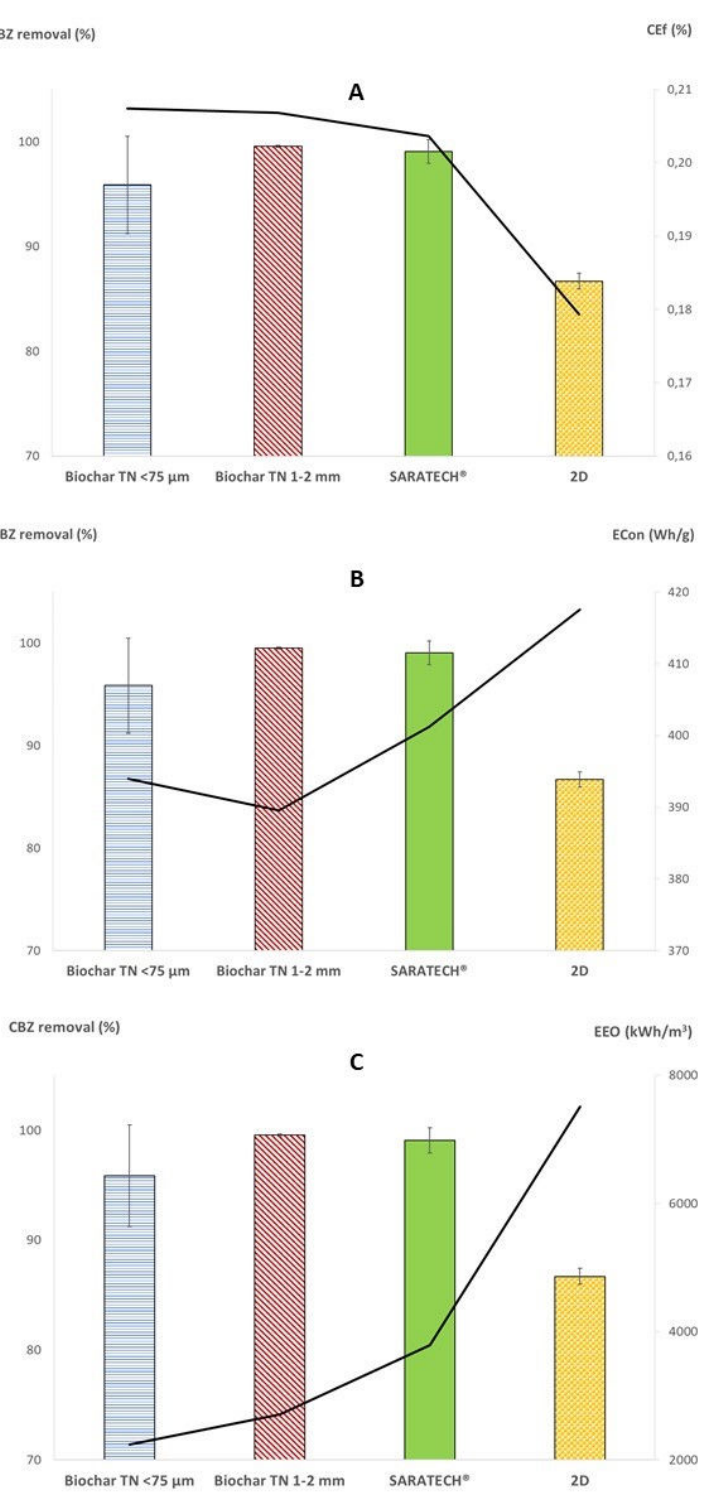
Figure 13. Effect of the particulate electrode on the removal of CBZ, represented by bars, and on energy consumption ( A ), current efficiency ( B ), and electric energy per order ( C ), repre- sented by the black lines, and comparison between the 2D and the 3D process (operational conditions: j = 6.67 mA/cm 2 ; NaCl = 0.1 M; CBZi = 10 mg/L; pH = 7; reaction time = 45 min; interelec- trode distance = 7.5 cm; particulate electrode = 1 mg/mL solution; cathode = STS; anode =